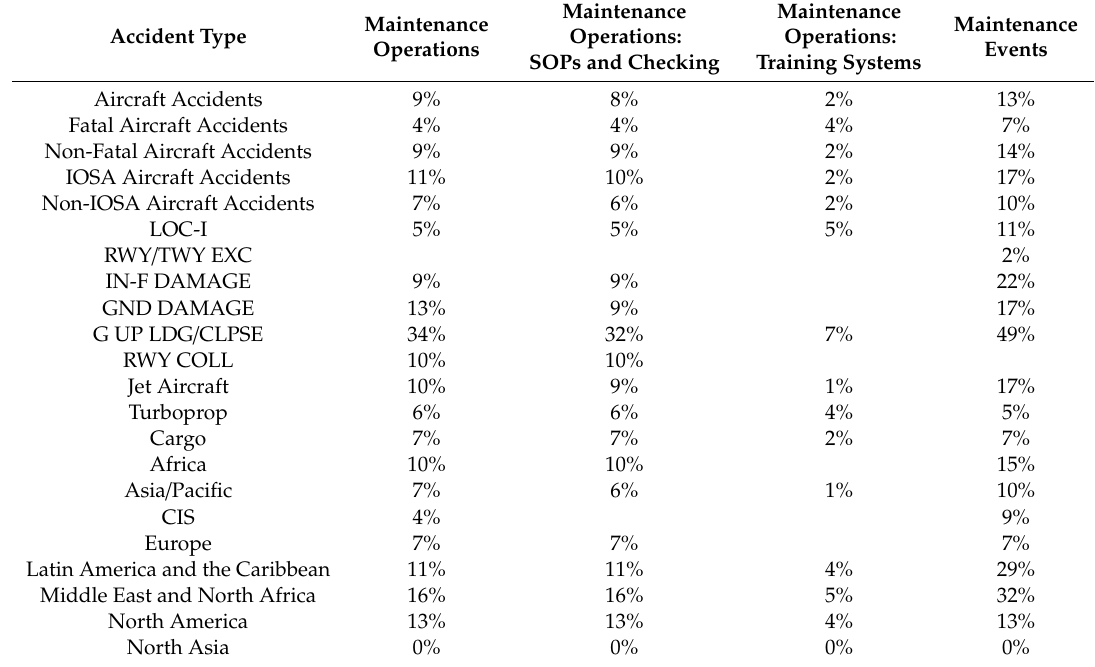
Table A1. IATA 2019 Safety